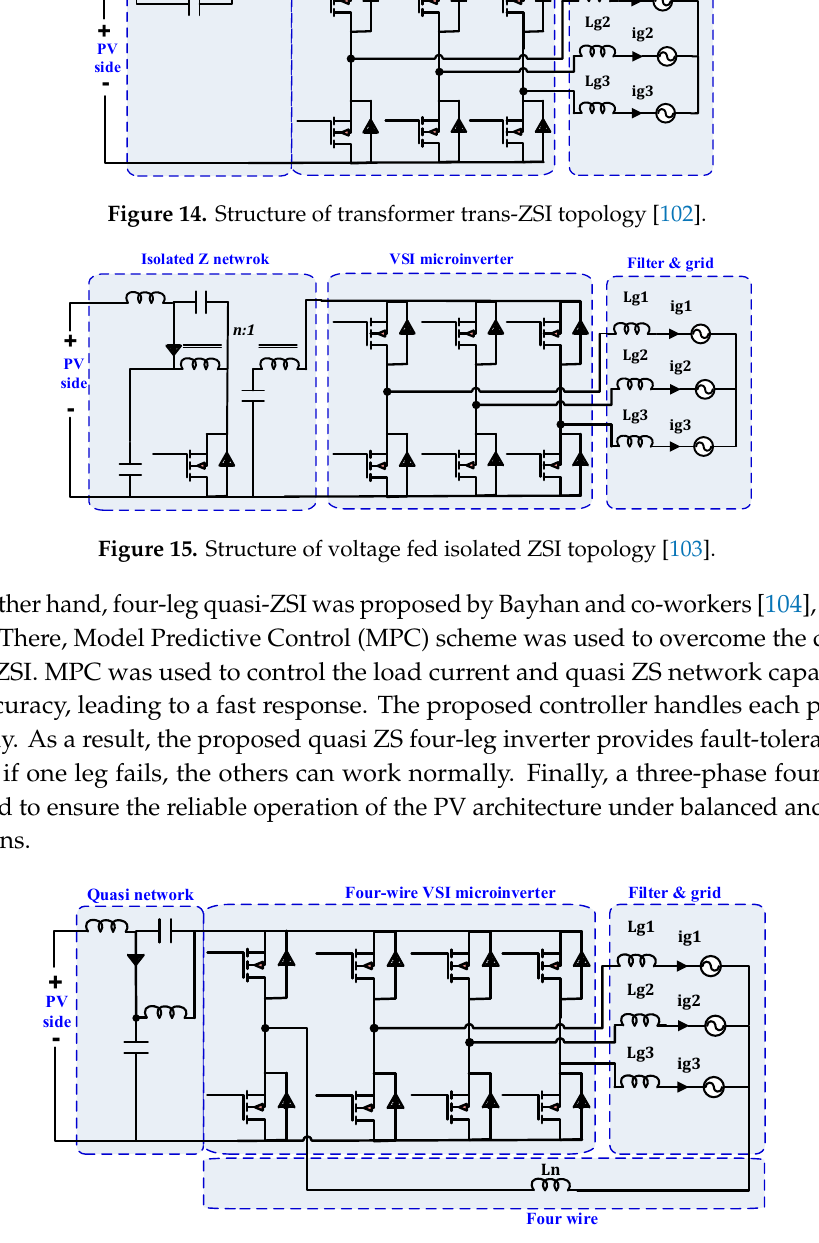
Figure 16. Quasi Z-source three-phase four-leg inverter topology [104].